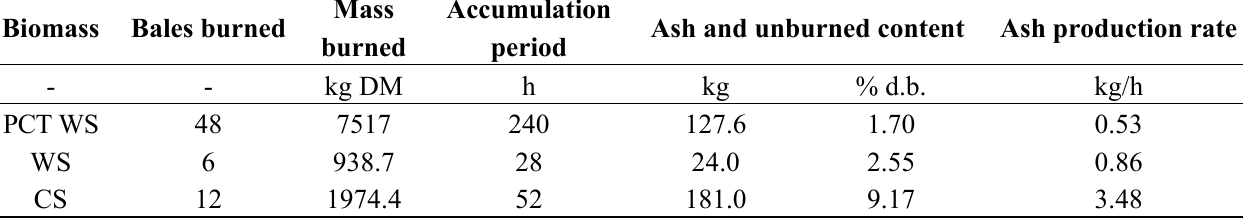
Table 3. Ash content from pre-combustion trial (PCT) WS and individually monitored WS and CS bales during January 2012 combustion trials.